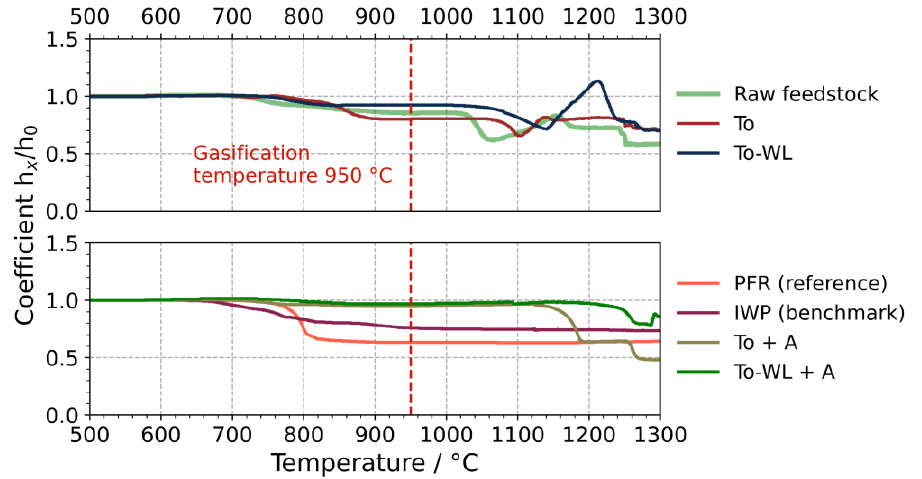
Figure 9. Height profile of ashes investigated by HSM in dependence of increasing temperature. The dashed red line denotes the defined gasification temperature of 950 °C.